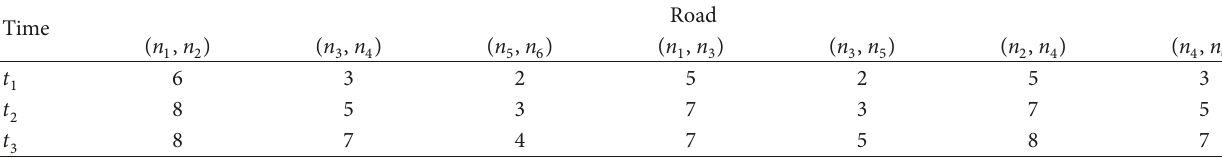
Table 3: Road risk level of the network in Figure 2 by traditional model.